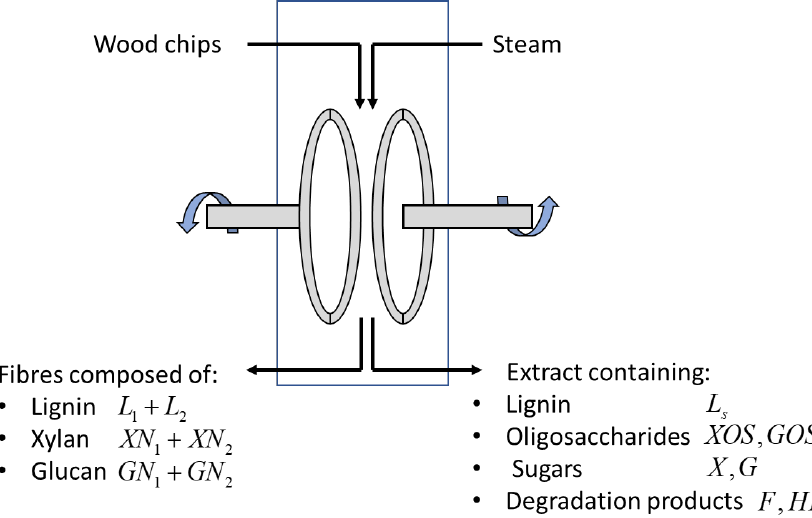
Figure 4. Schematic representation of a steam